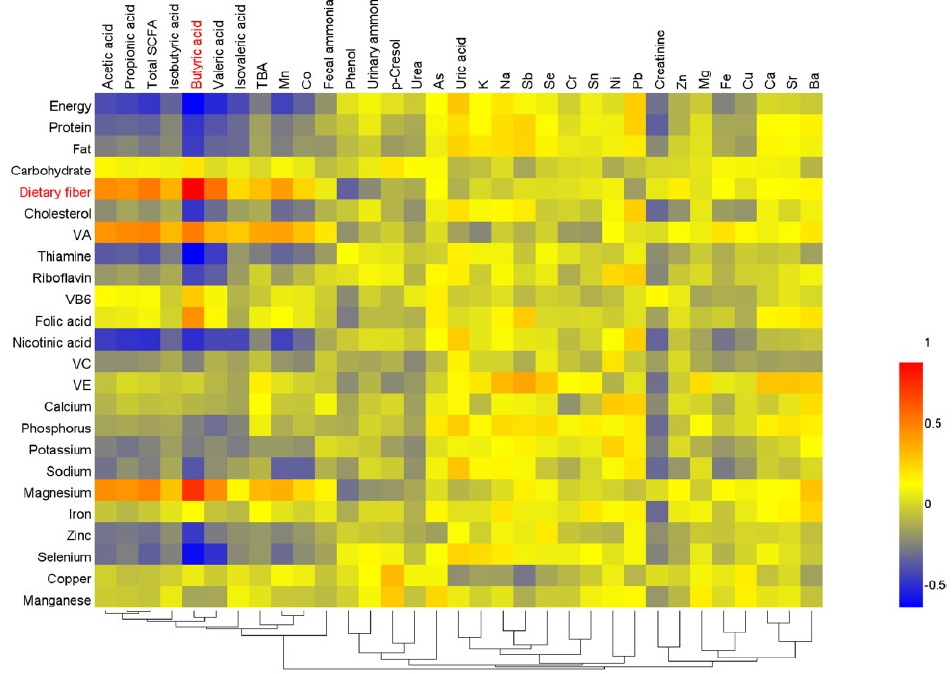
Figure 6. Correlations between the nutrient intake and metabolites as well as element levels. Red denotes positive correlation, blue denotes negative correlation, and yellow denotes no correlation.